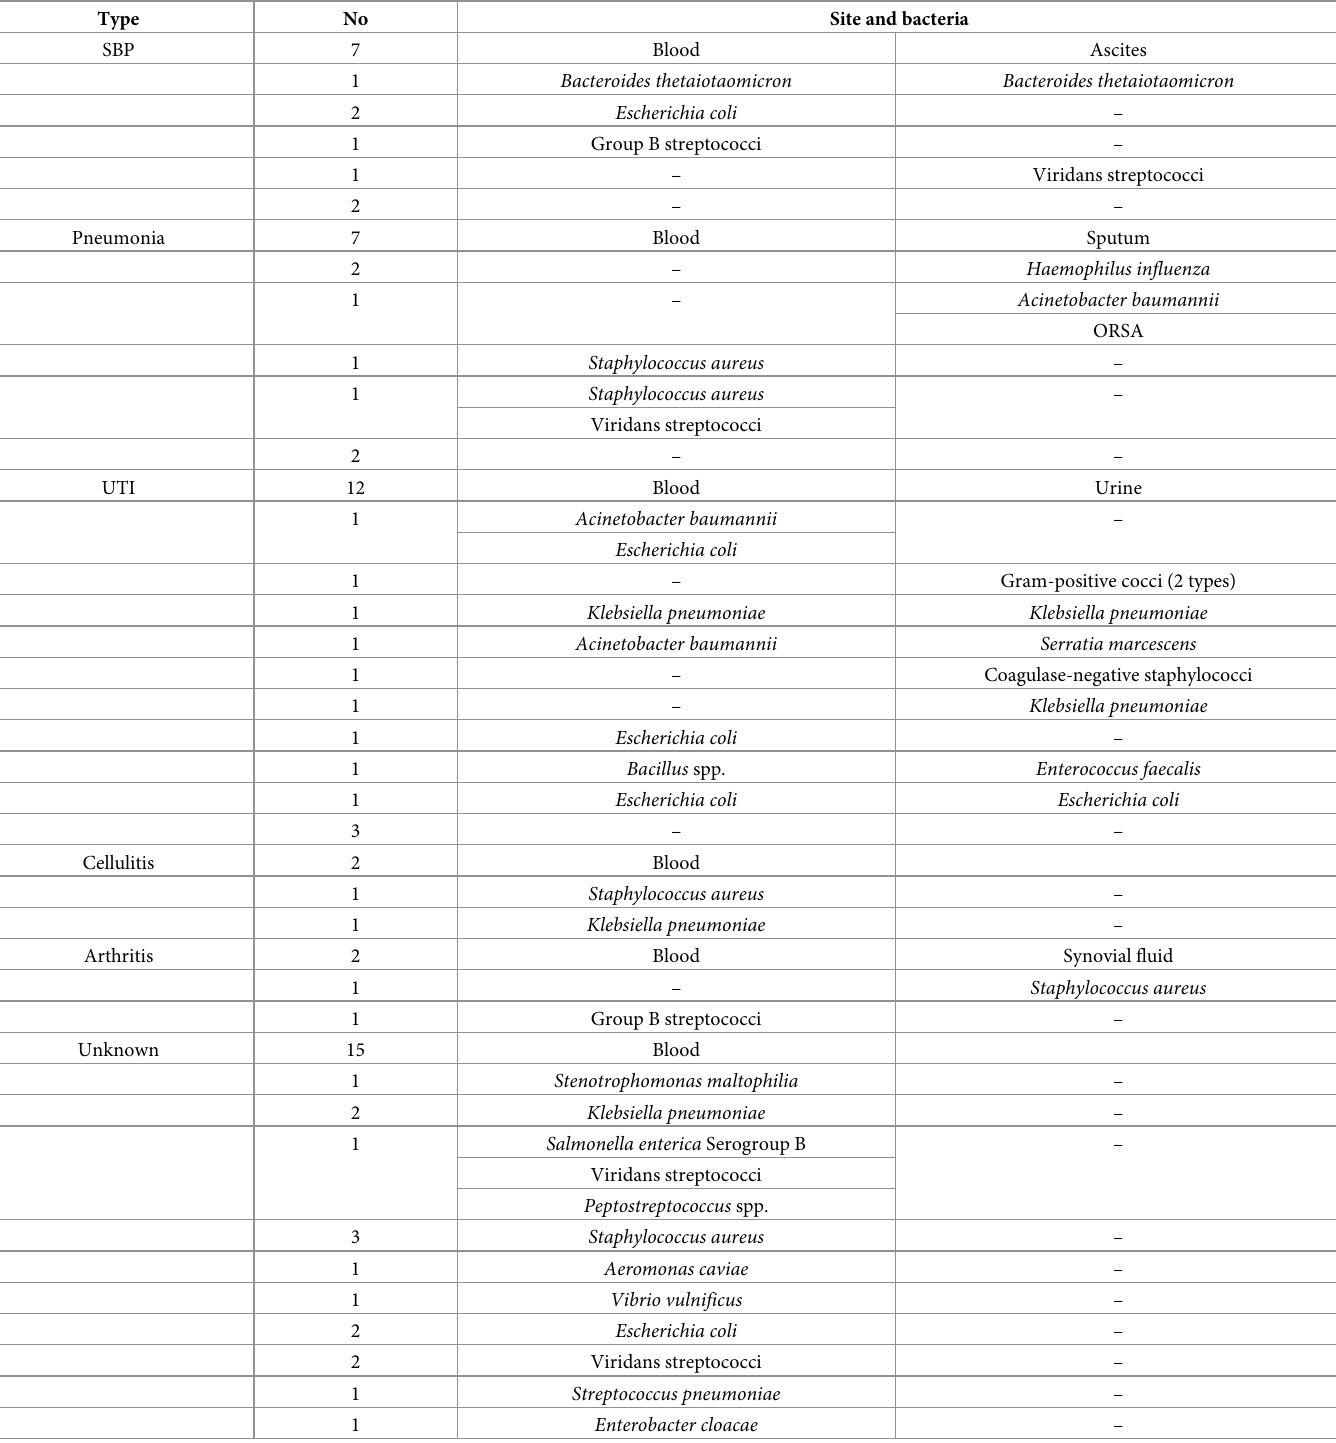
Table 4. Types of bacterial infection within 14 days (n =